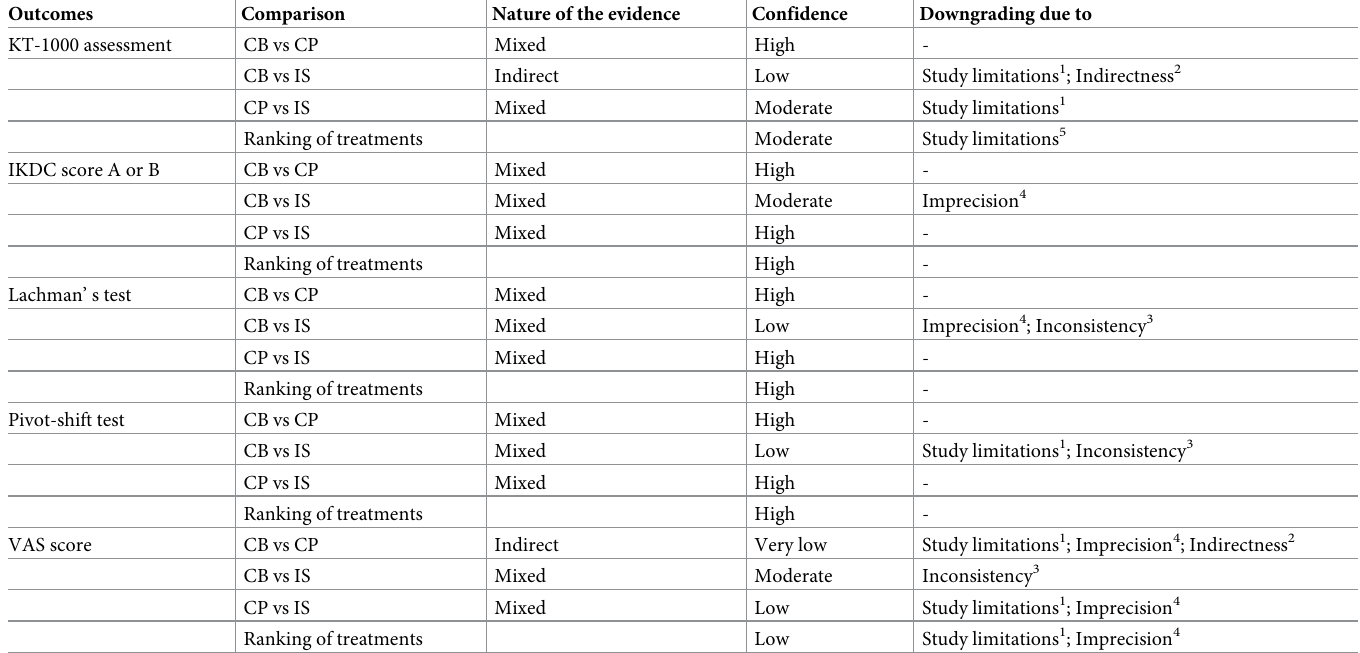
Table 2. Summary of our confidence in effect estimates and ranking of femoral fixation